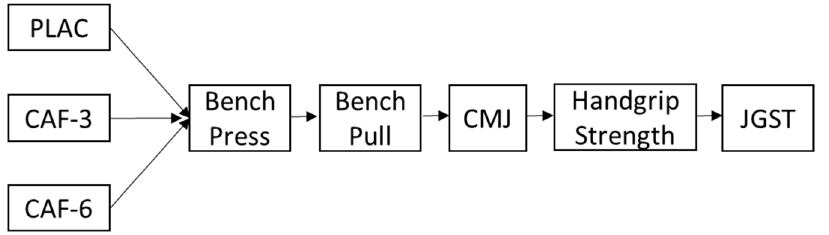
Figure 1. Study design. PLAC: placebo; CAF 3: a dose of 3 mg/kg of caffeine; CAF-6: a dose of Figure 1 . Study design. PLAC: placebo; CAF 3: a dose of 3 mg/kg of caffeine; CAF ‐ 6: a dose of 6 6 mg/kg of caffeine; CMJ: countermovement jump; JGST: Judogi Grip Strength mg/kg of caffeine; CMJ: countermovement jump; JGST: Judogi Grip Strength Test.